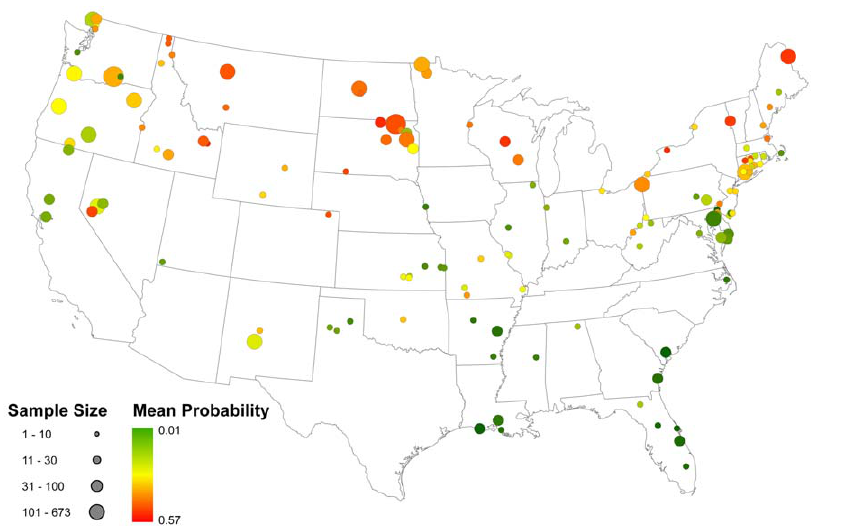
Figure 2. Top model estimate of average predicted probability that an individual bird sampled from local watersheds during the breeding season tests positive for avian influenza virus. The probability is an average across all three years of data for all waterfowl sampled within a given watershed. Note the strong latitudinal gradient with higher probabilities of testing positive in northern latitudes and decreasing probabilities in southern latitudes.